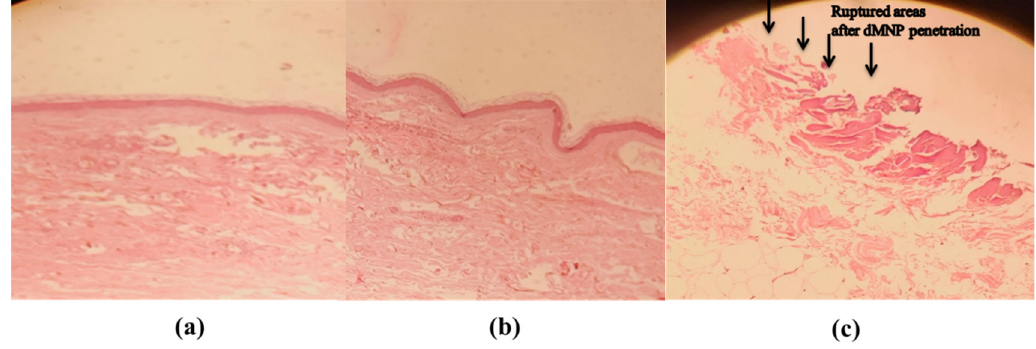
Figure 10. Histopathological examination of rabbit skin ( a ) before application of dMNP ( b ) after application of dMNP for 30 s and ( c ) after application of dMNP for 1 min.